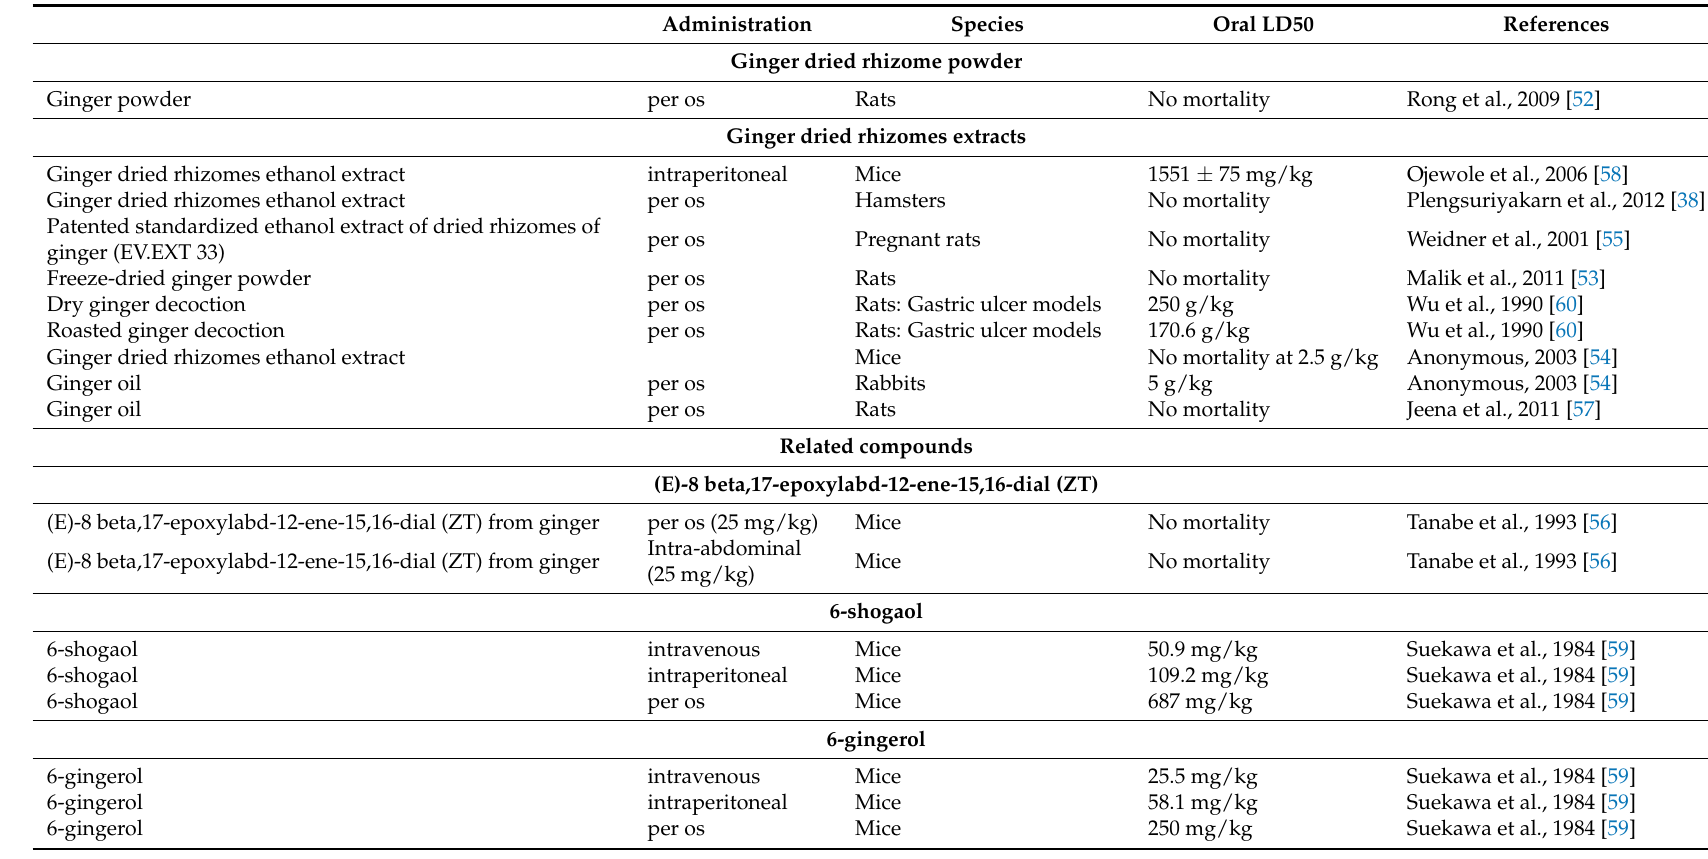
Table 8. Acute/subacute toxicity of ginger extracts and the main related